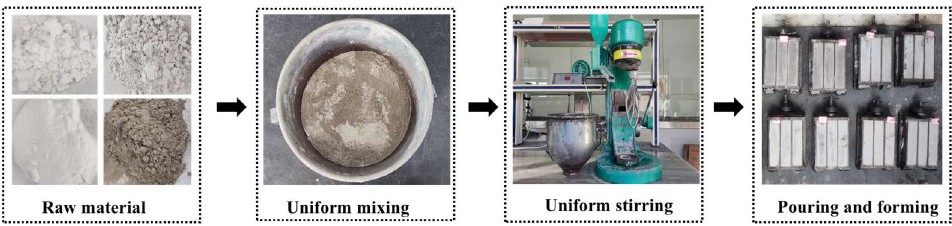
Figure 5. Specimen preparation of the geopolymer grouting materials.